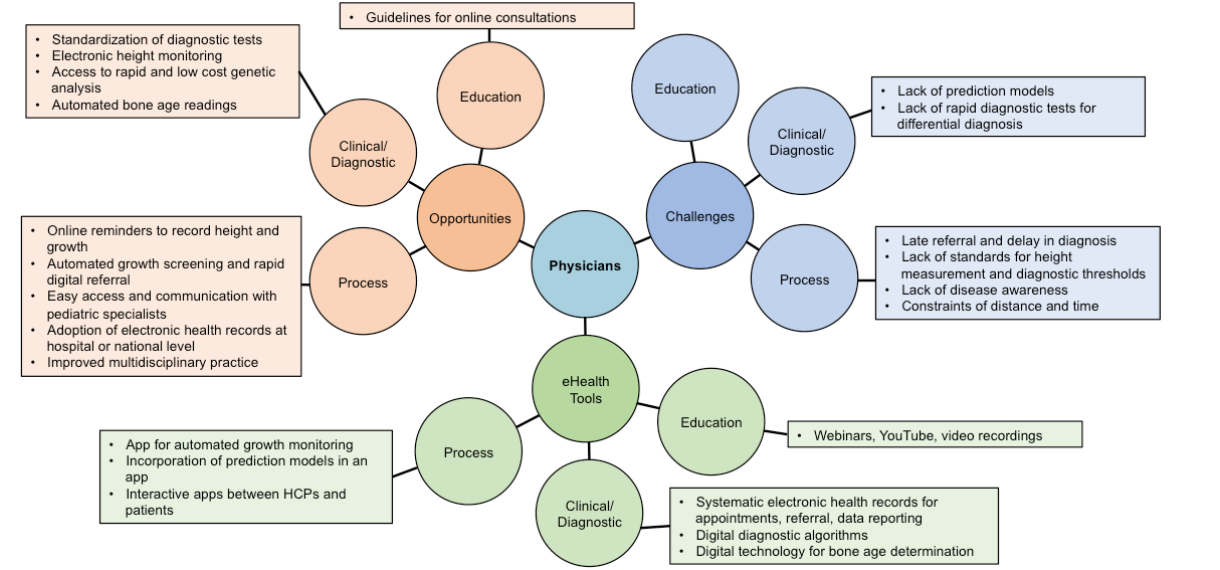
Figure 3. Physician viewpoints regarding referral and diagnosis stages of pediatric patients with growth failure. Where no comments box is shown, clinicians did not provide any opinions relating to that category. HCP: health care provider.